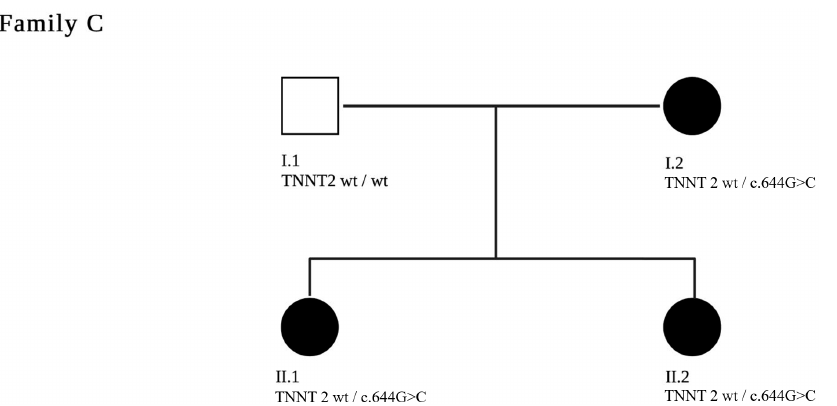
Figure 5. A two-generation pedigree of family C is shown. The index patient is C.II.1. The clinically a ff ected patients are marked in black. The c.644G>C pathogenic variant in TNNT2 segregated with disease in the genotyped individuals.